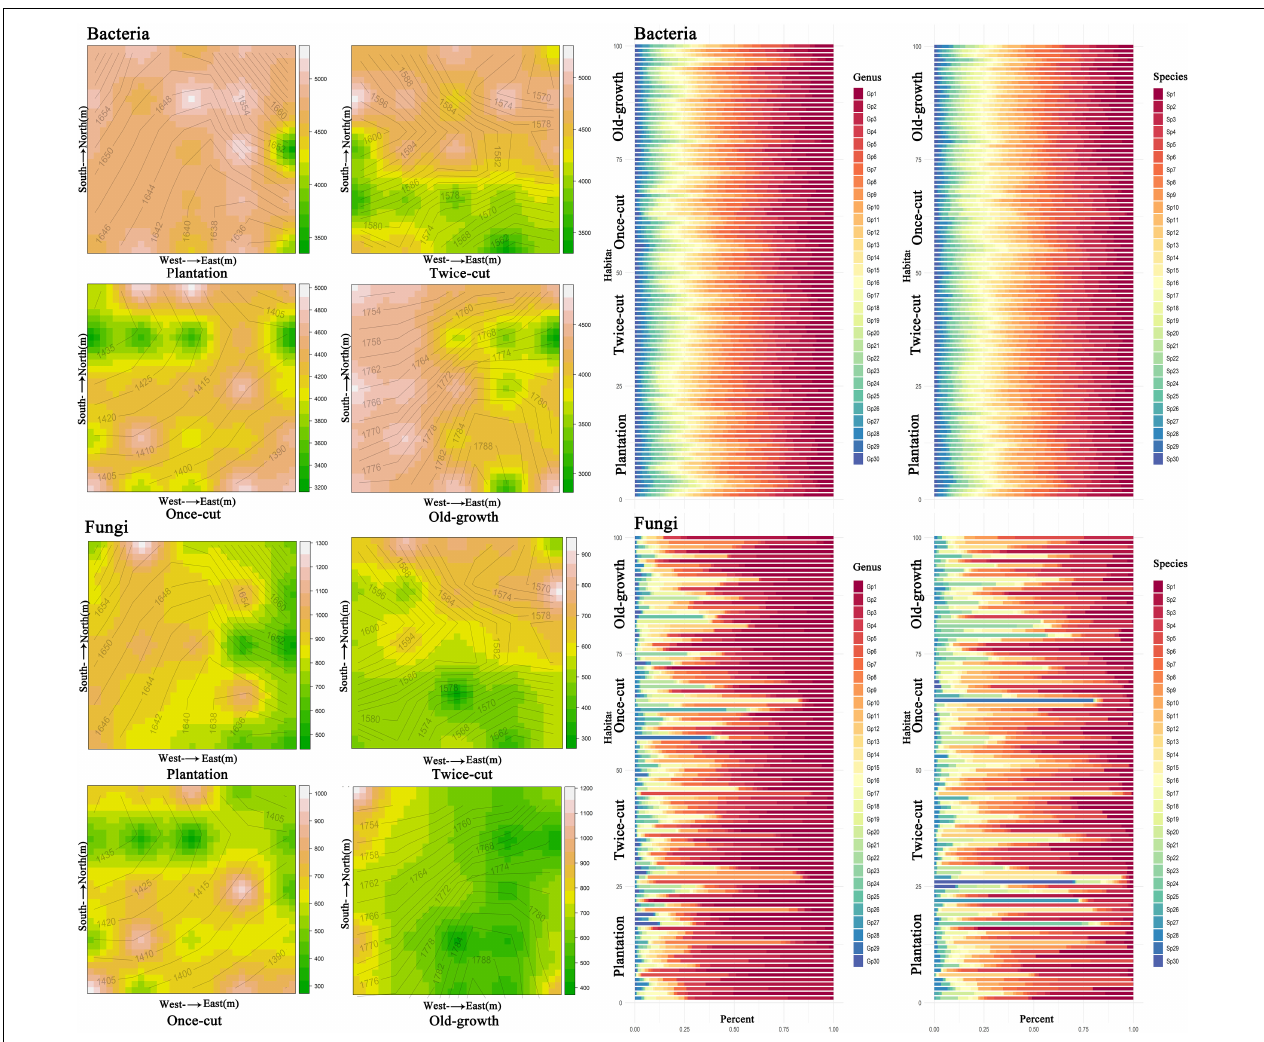
FIGURE 1 | Spatial distribution and composition of bacterial and fungal species diversity in the four forest succession in the sample plot. The species accumulation diagrams show the composition of bacteria and fungi at the genus and species levels, respectively. The top 30 genera and species were selected for abundance. The abscissa is the proportion of species in the sample, and the ordinate is the plot. Different colored columns represent different species, and the length of the columns represents the proportion of the size of the species. The abbreviations of species are shown in Supplementary Table 4 .